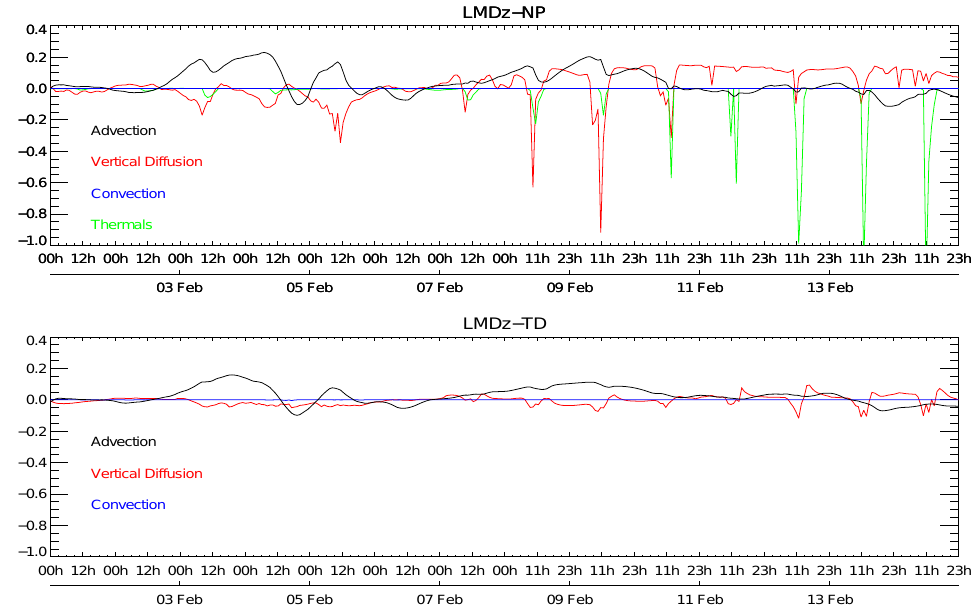
Figure 7. Time series of advection (black), vertical diffusion (red), convection (blue) and thermals (green) trends at Lutjewad station in the beginning of February 2008 for NP simulation (top) and TD simulation (bottom). The unit is Bqm − 3 h − 1